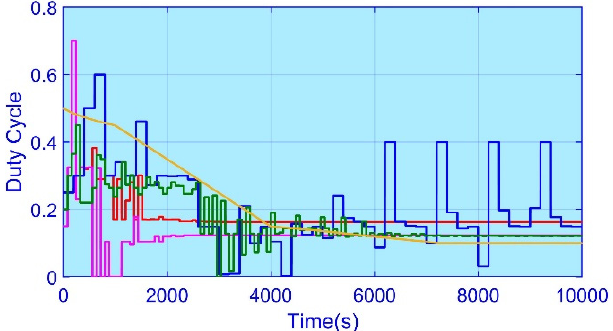
Figure 13. Comparison of the HOA duty-cycle for Case 1 .